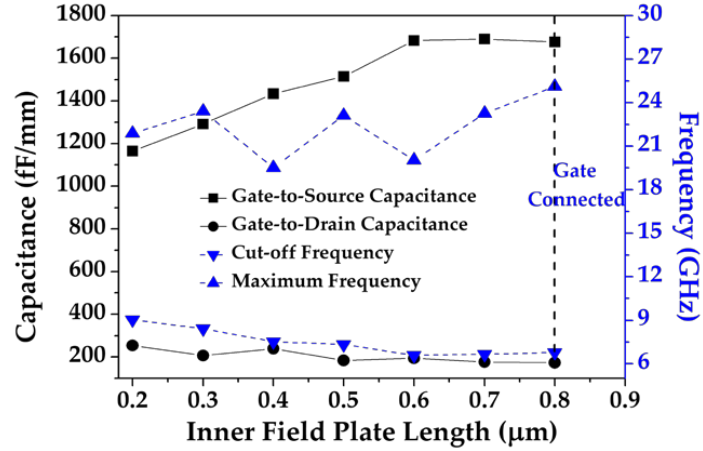
Figure 11. Capacitance and frequency variations as a function of IFP length changes.